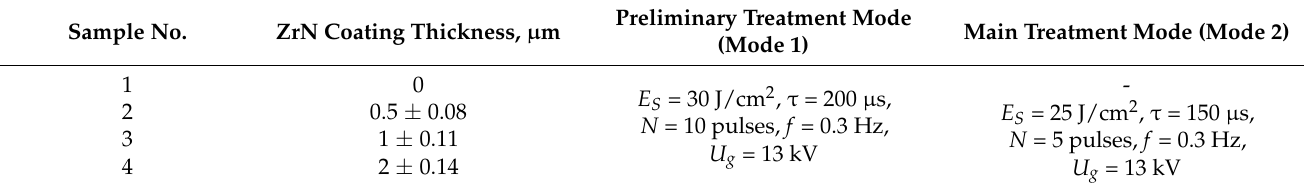
Table 1. Modes of electron beam treatment of the